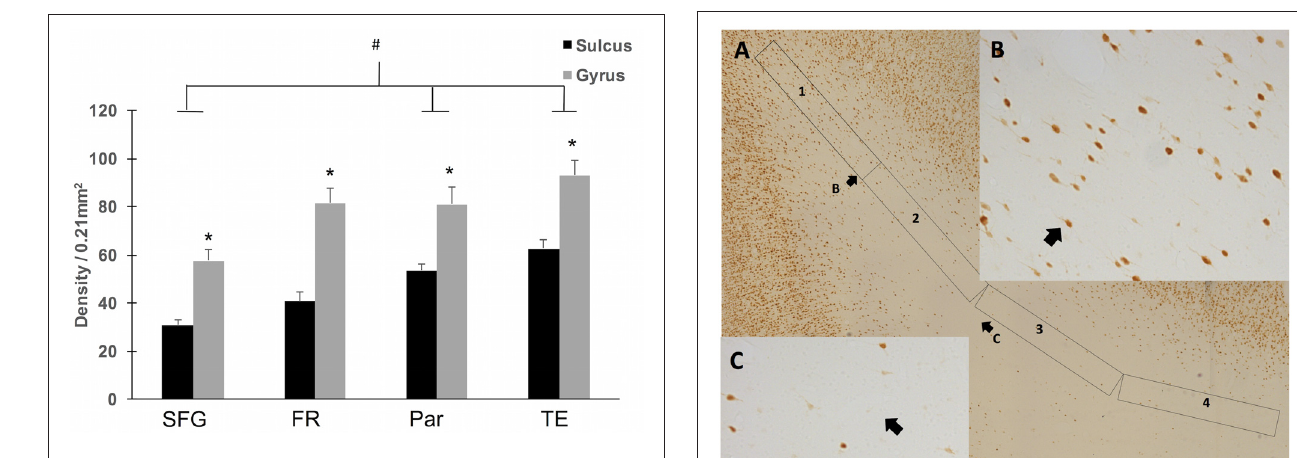
FIGURE 4 | Regional density of WMNs in sulcal depths and gyral crowns. All four regions showed significantly greater WMN density in the gyral crown compared to the sulcal depth ( ∗ p < 0.05). Across the four regions, both sulcal and gyral WMN density was least for cingulate (Cing)/SFG and greatest for the TE region. Temporal and parietal (Par) regional counts were significantly greater than counts for Cing/SFG ( # p < 0.05).